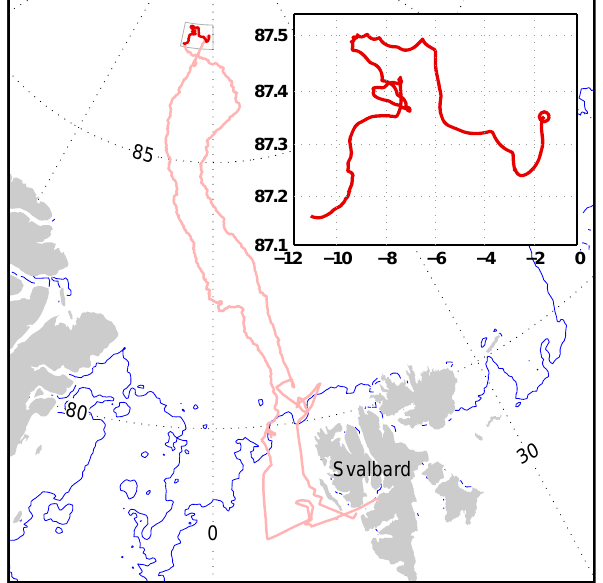
Fig. 1. Map of the ASCOS cruise track (pink) with ice-drift pe- riod highlighted (red, and inset area indicated) and (inset) shown in detail with the start of the drift marked by the circle. The ice edge (blue line) is shown for the start of the drift period on 12 Au- gust 2008.